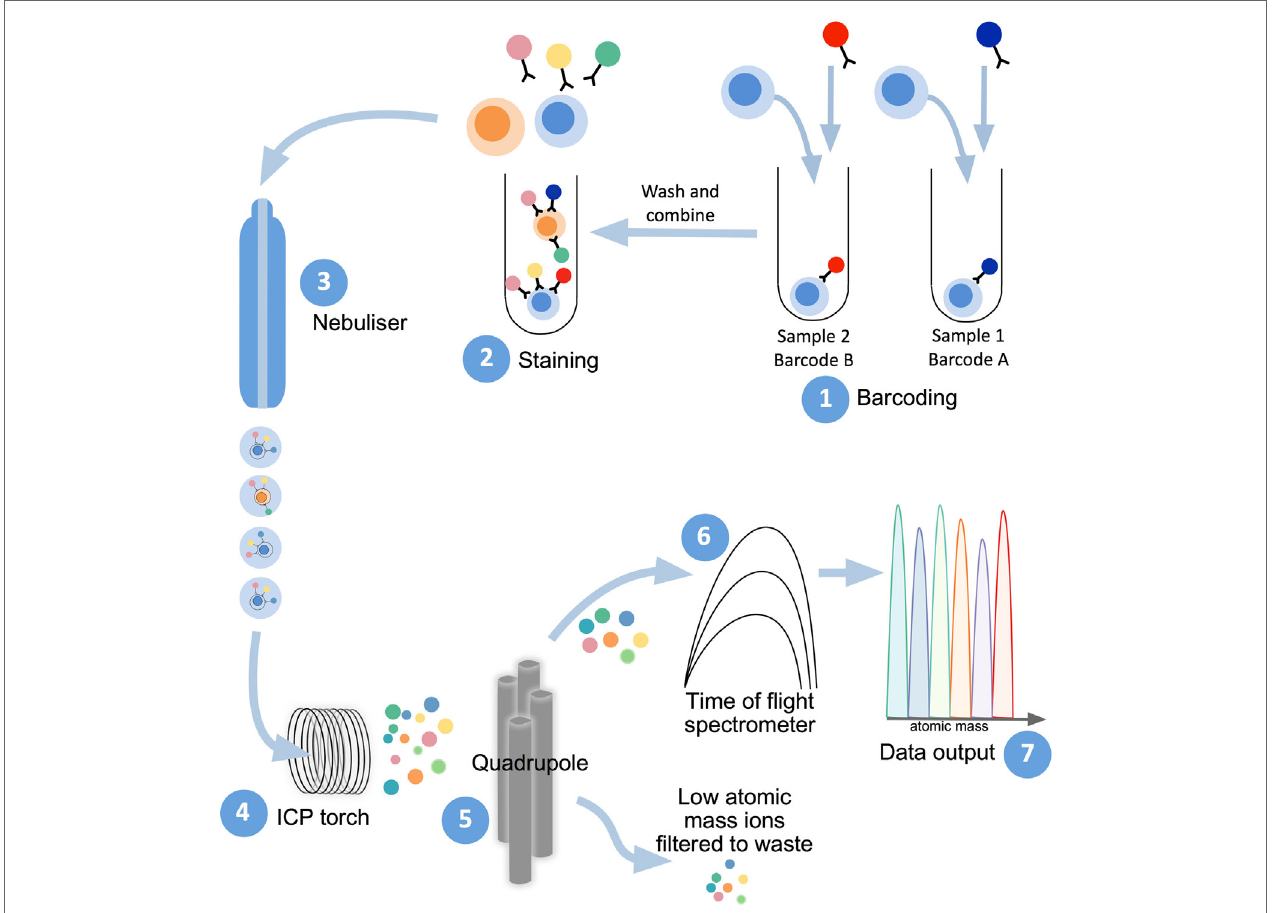
FiGURe 2 | Mass cytometry workflow. Sample preparation consists of labeling with lanthanide-conjugated antibodies, first by differentially metal-labeled CD45 antibodies (so each sample has a different “barcode”) (1), which will then allow for mixing of multiple samples for DNA and immunophenotyping antibody staining (2). For acquisition of prepared samples, the following steps take place: cells are separated into individual droplets containing one cell each in the nebulizer (3). Each cell-containing droplet is passed through an inductively coupled plasma (ICP) torch to superheat, vaporize, atomize, and ionize each cell (4). Ions below 80 Da are filtered out with a series of radio frequency quadrupoles (5) with the remaining, high-atomic mass metal ions analyzed with time-of-flight mass spectrometry (6). Resultant signals are attributed to single cells and read out as .flow cytometry standard files (7) to allow for downstream